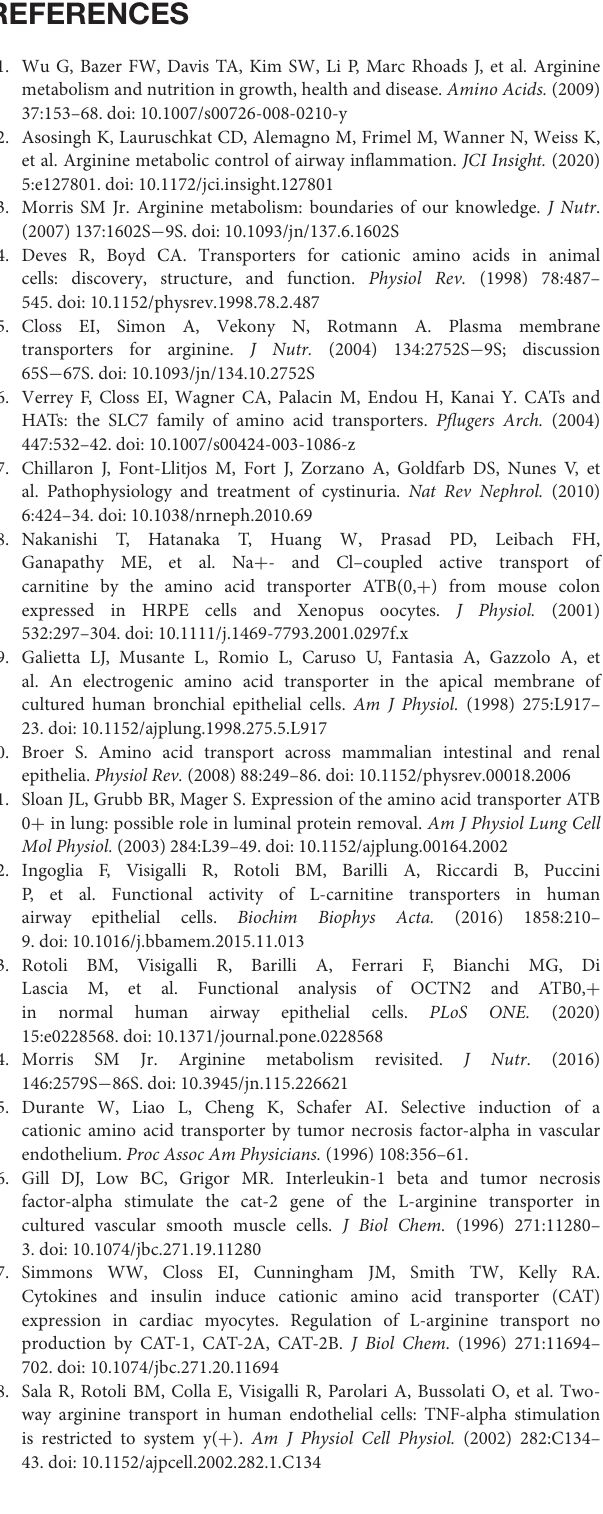
Supplementary Figure 1 | The expression of toll-like receptor-5 (TLR5) was measured by means of RT-qPCR analysis and shown after normalization for that of the housekeeping gene (RPL15) . Data of the three different cultures are